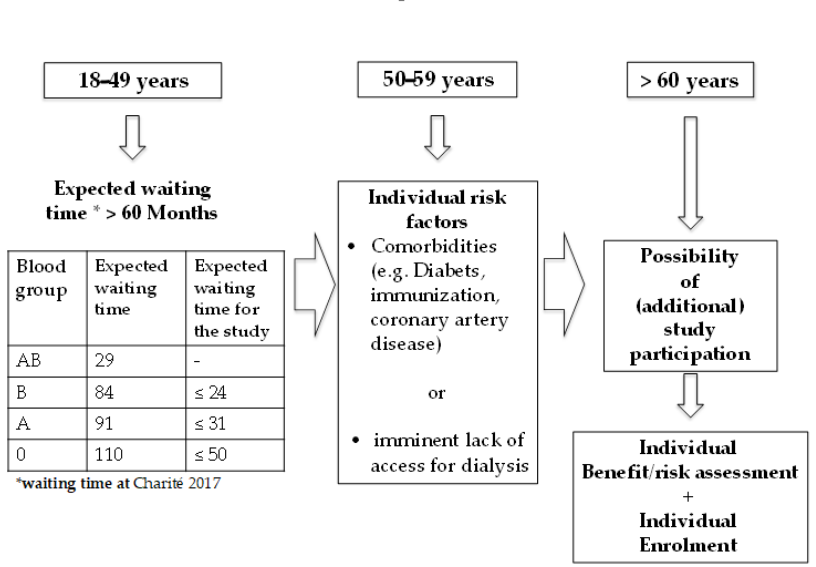
Figure 1. Decision criteria for participation in the study. Patients were stratified on a clinical decision model to detect a target population with elevated mortality risk.